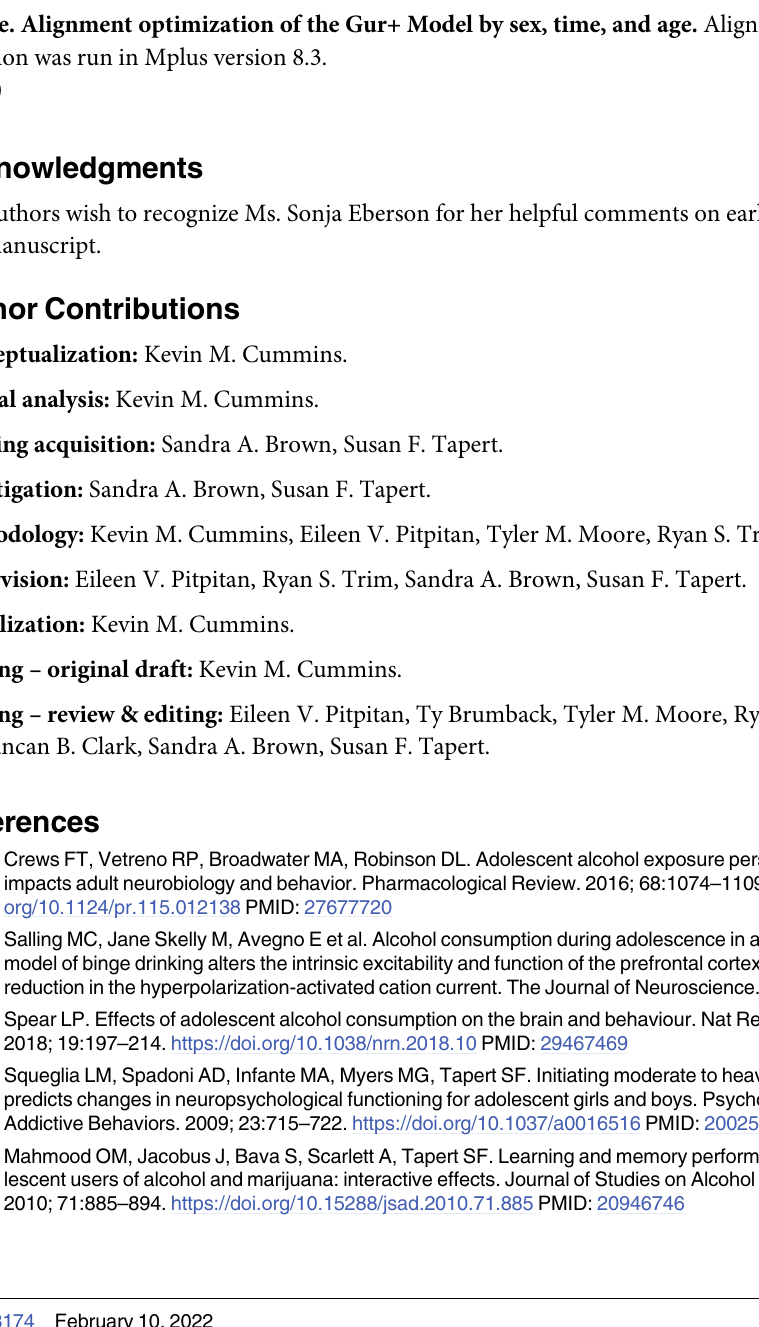
S1 Table. Confirmatory factor analysis model fit comparisons in models fit with